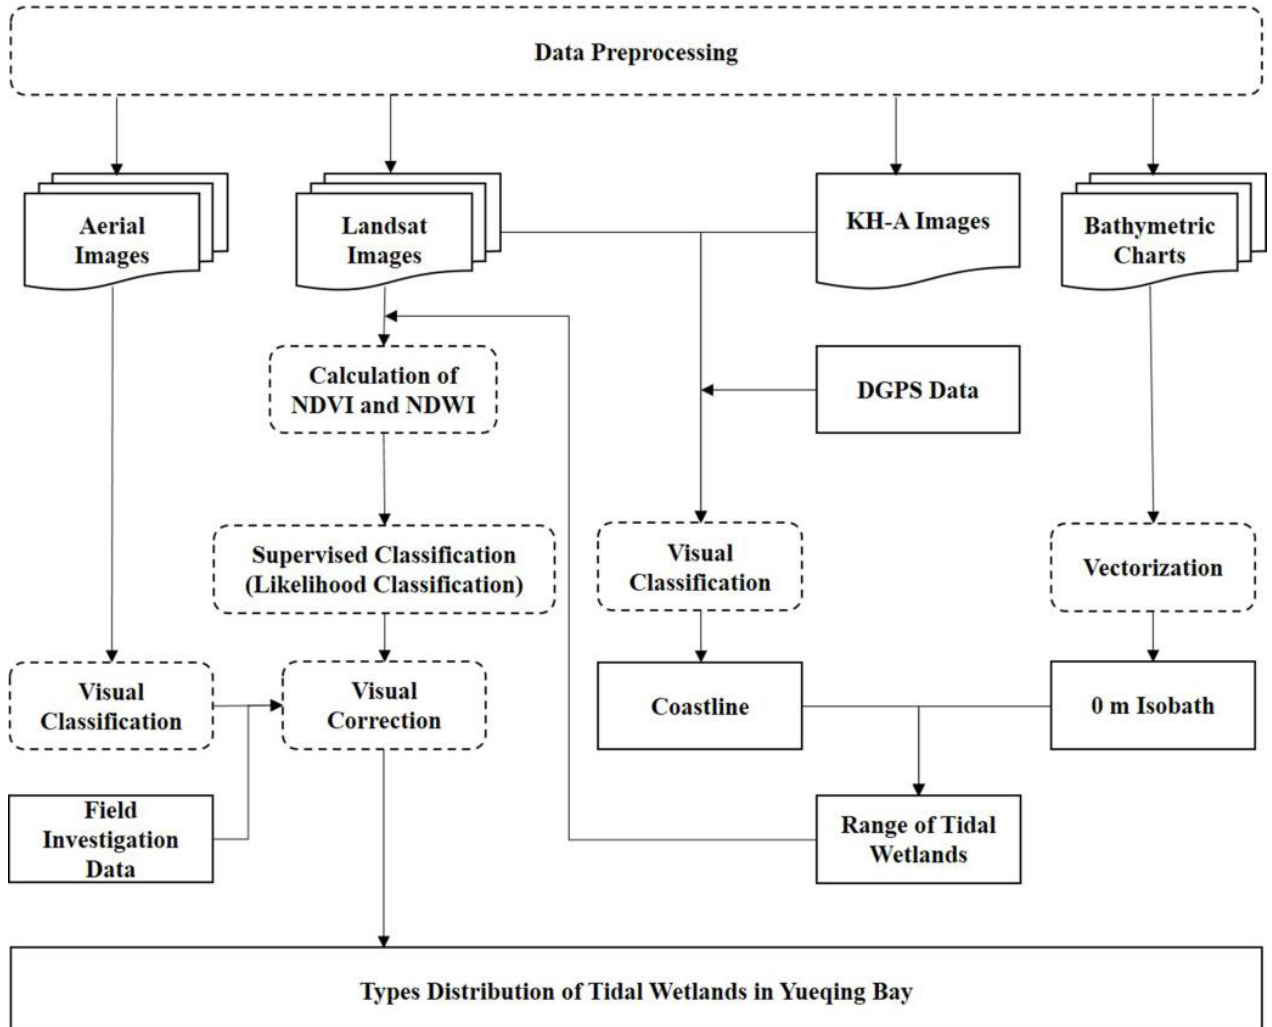
Figure 2. The technical process used for tidal wetland classification.